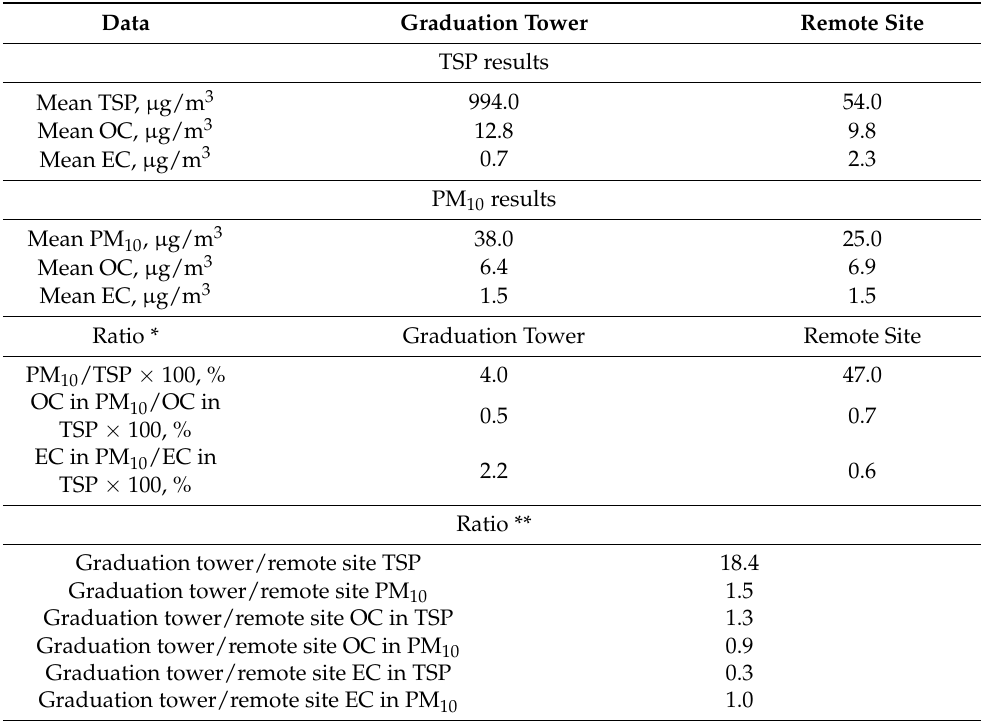
Table 1. Mean concentrations of TSP, PM 10 and organic carbon OC and elemental EC associated with these fractions and the ratios of selected